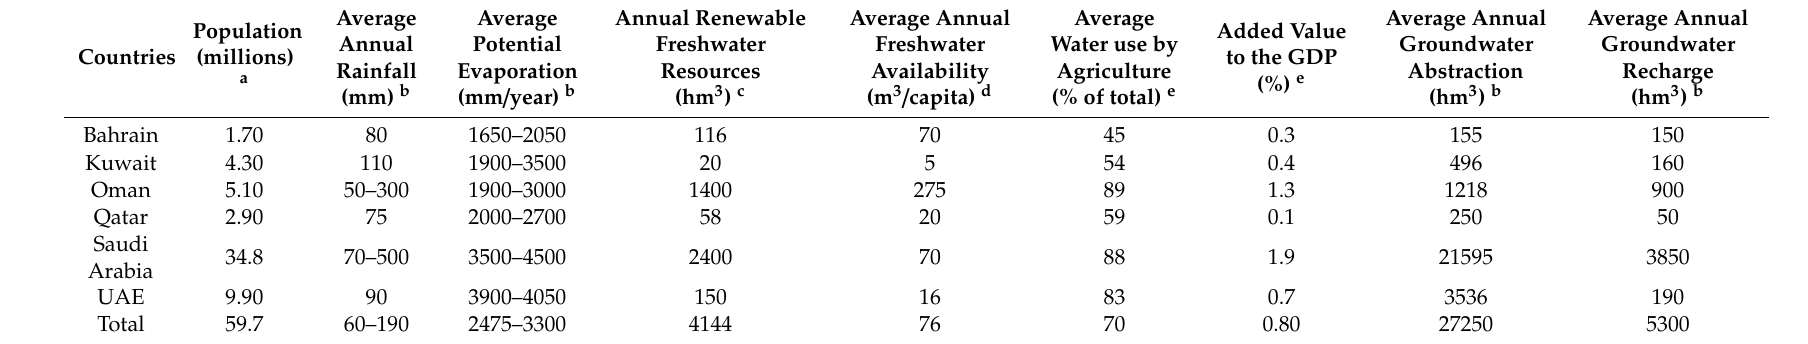
Table 1. Summary of water resources in the GCC